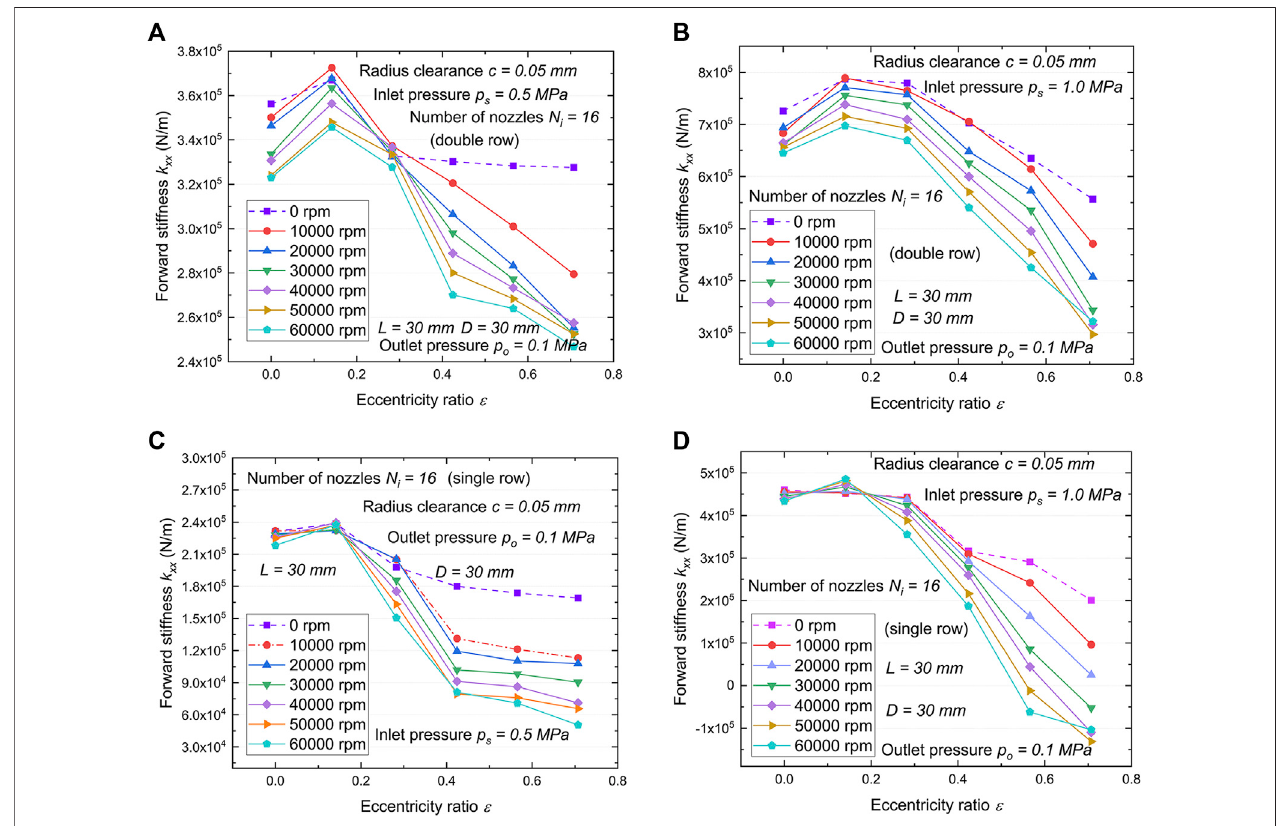
FIGURE 8 | Variations of forward stiffness coef fi cient k xx with eccentricity ratio. (A) Double row, p s = 0.5 MPa. (B) Double row, p s = 1.0 MPa. (C) Single row, p s = 0.5 MPa. (D) Single row, p s = 1.0